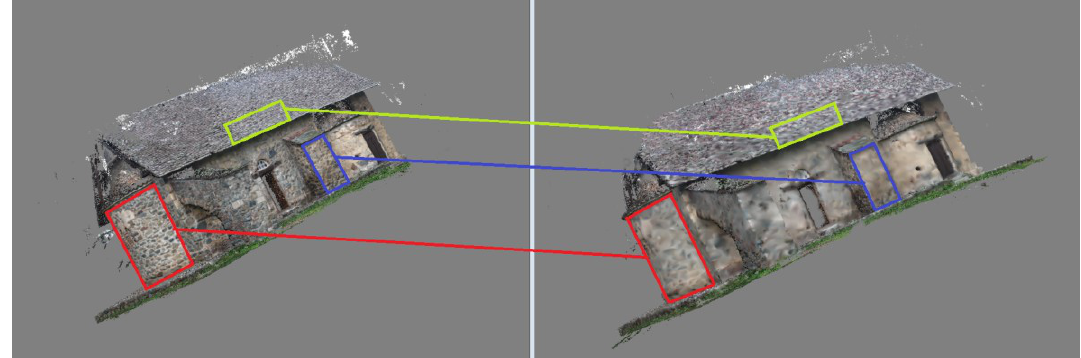
Figure 7. The implementation of the proposed modelling approach on the Asinou